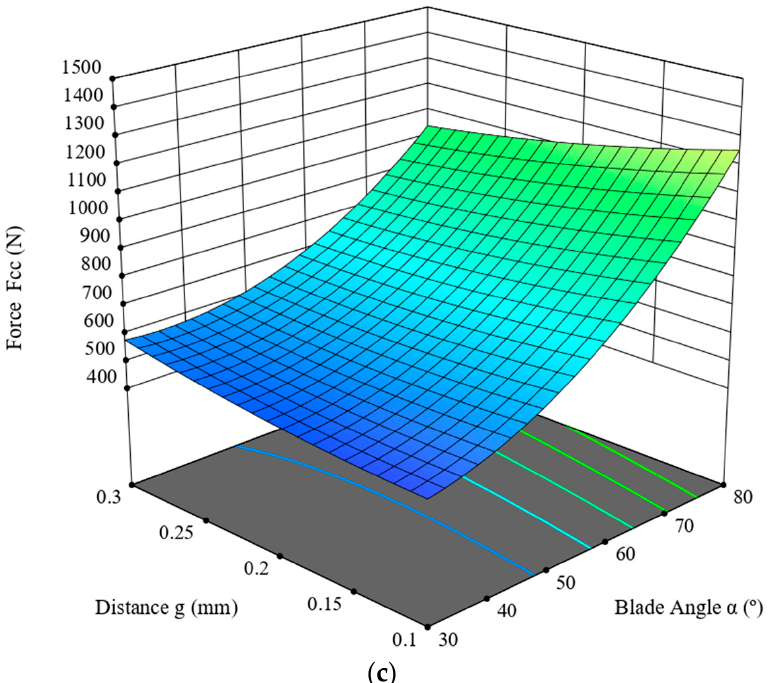
Figure 7. Cutting force value, F cc , in the function of the blade angle, α , of the distance, g, for velocity value ( a ) V = 1 mm/s, ( b ) V = 4 mm/s and ( c ) V = 8 mm/s.